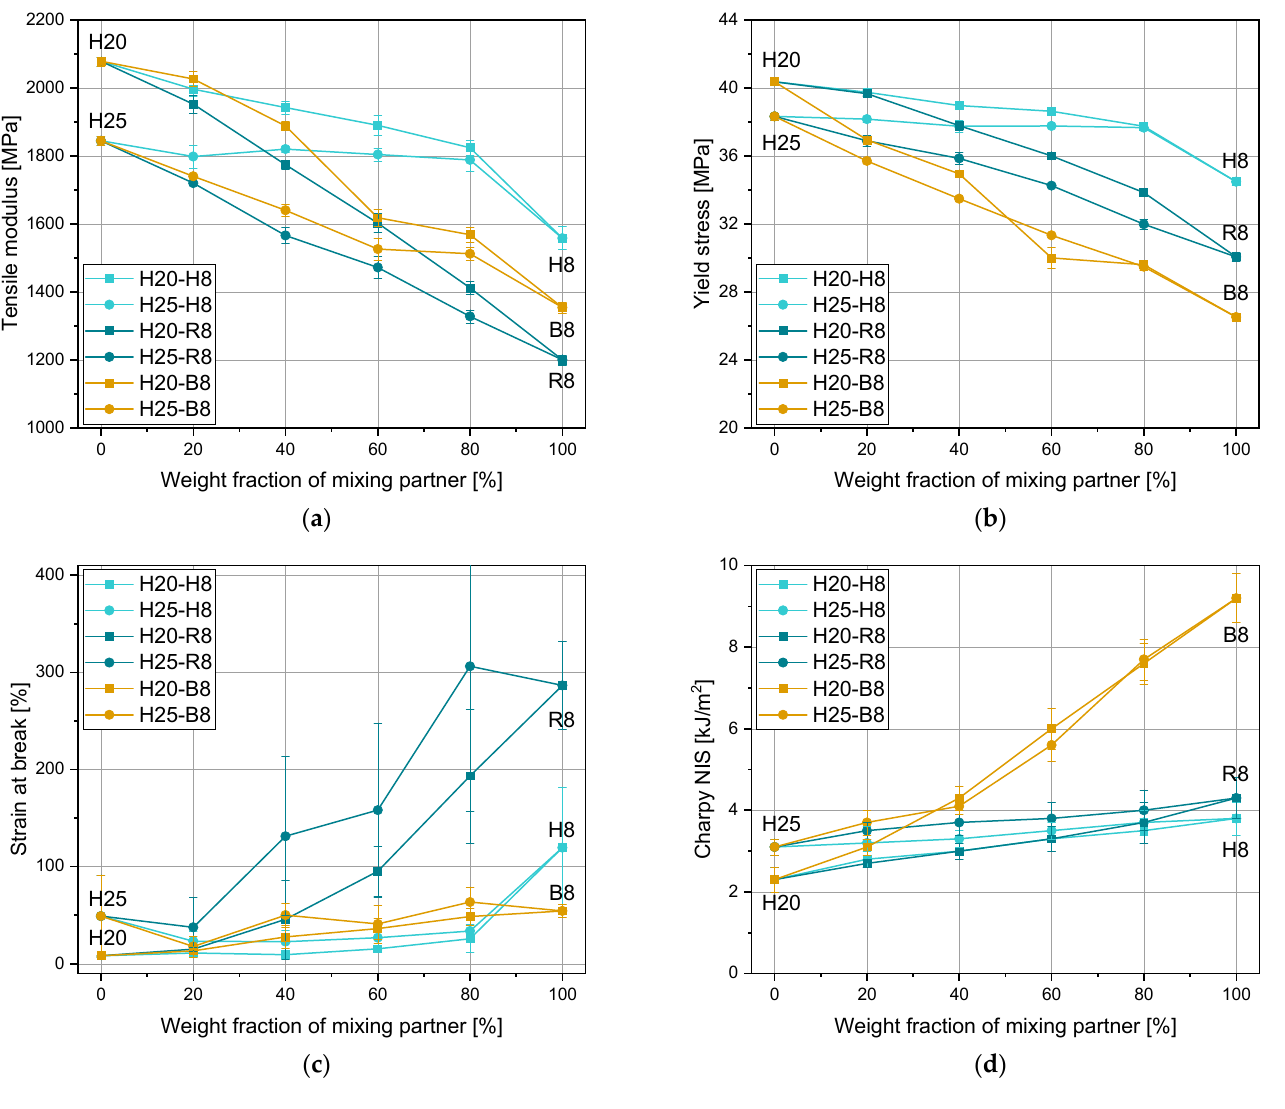
Figure 4 . Mechanical properties ( a ) tensile modulus, ( b ) yield stress, ( c ) strain at break, and ( d ) Charpy NIS of blends with extrusion materials H8, R8, and B8.